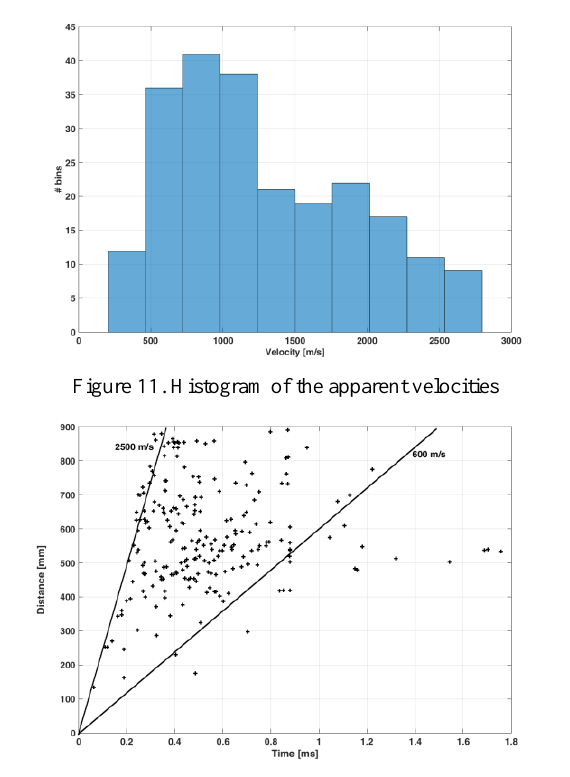
Figure 12. Distance d versus Time TB plot.